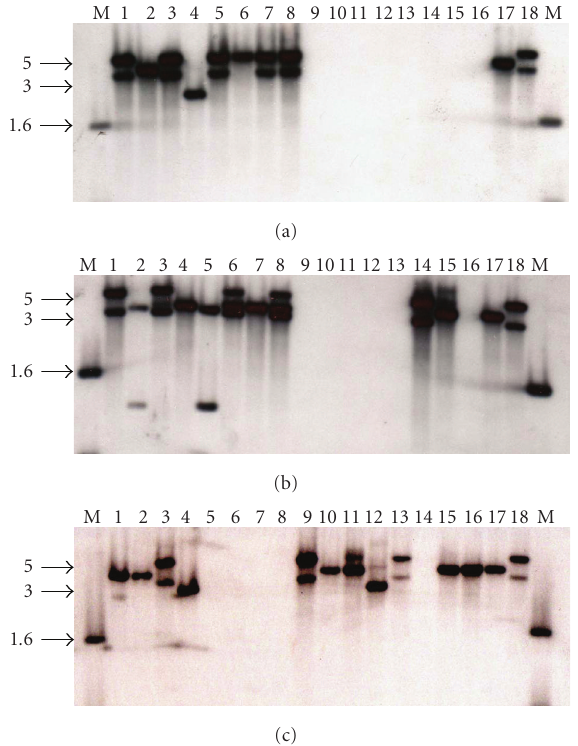
Figure 1: Southern analysis of chromosomal DNA from Staphylo- coccus species hybridized with a probe specific for hysA . Panel (a) S. aureus NCH 239 (1), NCH 240 (2), NCH 241 (3), NCH 242 (4), NCH 243 (5), NCH 244 (6), NCH 245 (7), NCH 246 (8), S. auricularis ATCC 33753 T (9), S. capitis subsp. capitis ATCC 27840 T (10), S. caprae ATCC 35538 T (11), S. carnosus subsp. carnosus ATCC 51365 T (12), S. chromogenes ATCC 43764 T (13), S. cohnii subsp. cohnii ATCC 29974 T (14), S. delphini ATCC 49171 T (15), S. hominis subsp. hominis ATCC 27844 T (16), S. aureus NCH 78 (17), and NCH 88 (18). Panel (b) S. aureus NTH 74 (1), NTH 75 (2), NTH 76 (3), NTH 77 (4), NTH 78 (5), NTH 79 (6), NTH 80 (7), NTH 81 (8), S. intermedius ATCC 29663 T (9), S. lugdunensis ATCC 43809 T (10), S. saprophyticus ATCC 19701 T (11), S. schleiferi subsp. schleiferi ATCC 43808 T (12), S. epidermidis ATCC 12228 (13), S. aureus NTH 125 (14), NCH 265 (15), S. intermedius ATCC 29633 T (16), NCH 78 (17), and NCH 88 (18). Panel (c) S. aureus NCH 47 (1), NCH 48 (2), NCH 49 (3), NCH 51 (4), S. sciuri subsp. sciuri ATCC 29062 T (5), S. simulans ATCC 27848 T (6), S. warneri ATCC 27836 T (7), S. xylosus ATCC 29971 T (8), S. aureus NTH 13 (9), NCH 78 (10), NCH 79 (11), NTH 82 (12), NCH 88 (13), S. haemolyticus ATCC 29970 T (14), NCH 328 (15), NCH 331 (16), NCH 78 (17), and NCH 88 (18). M: marker (kilobases).